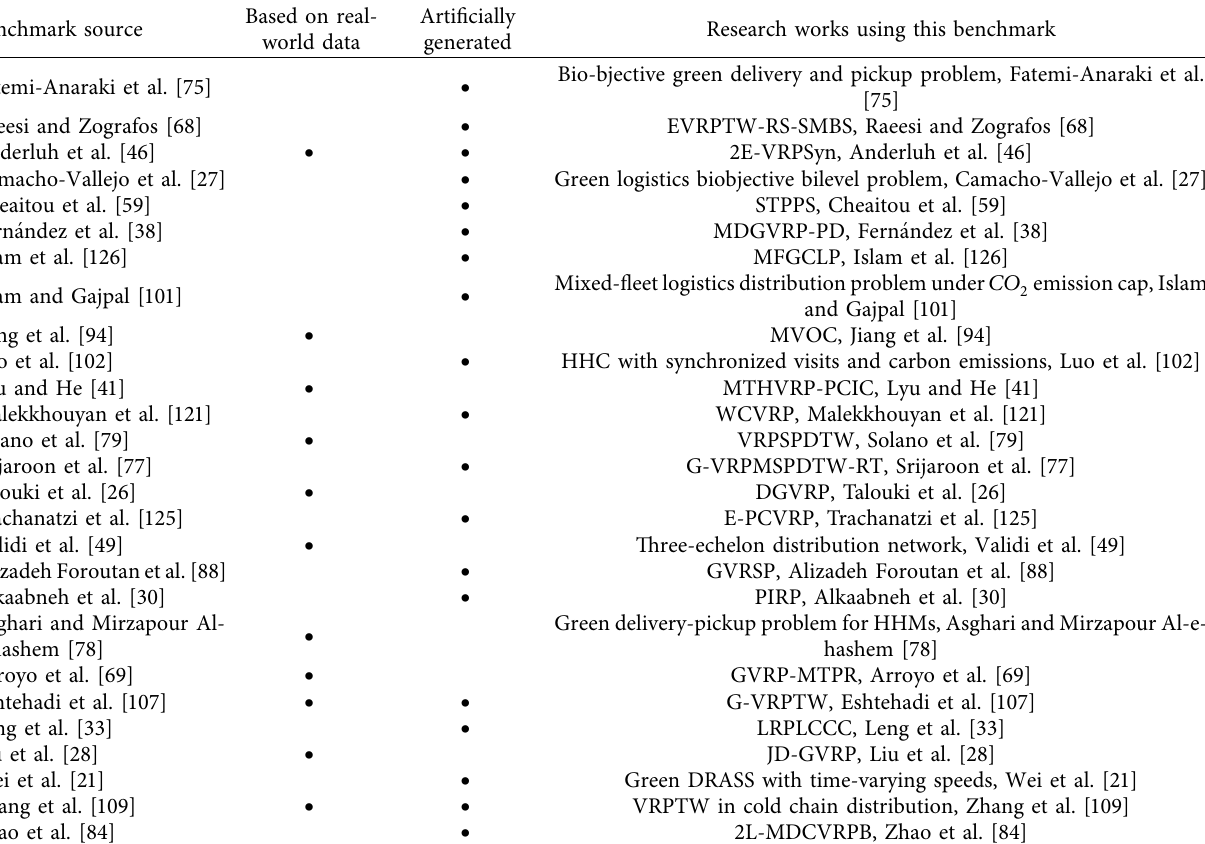
Figure 6: Distribution of proposed solution methods for GVRPs. +e pie chart displays the percentage of use of each method among the reviewed articles. Table 3: Benchmarks used for the